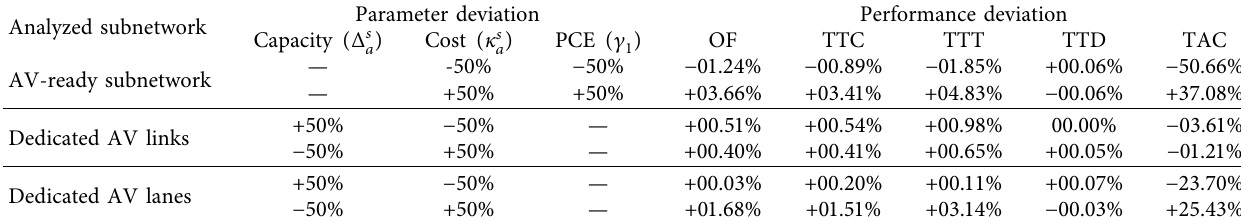
Table 7: Sensitivity analysis for 50% MPR